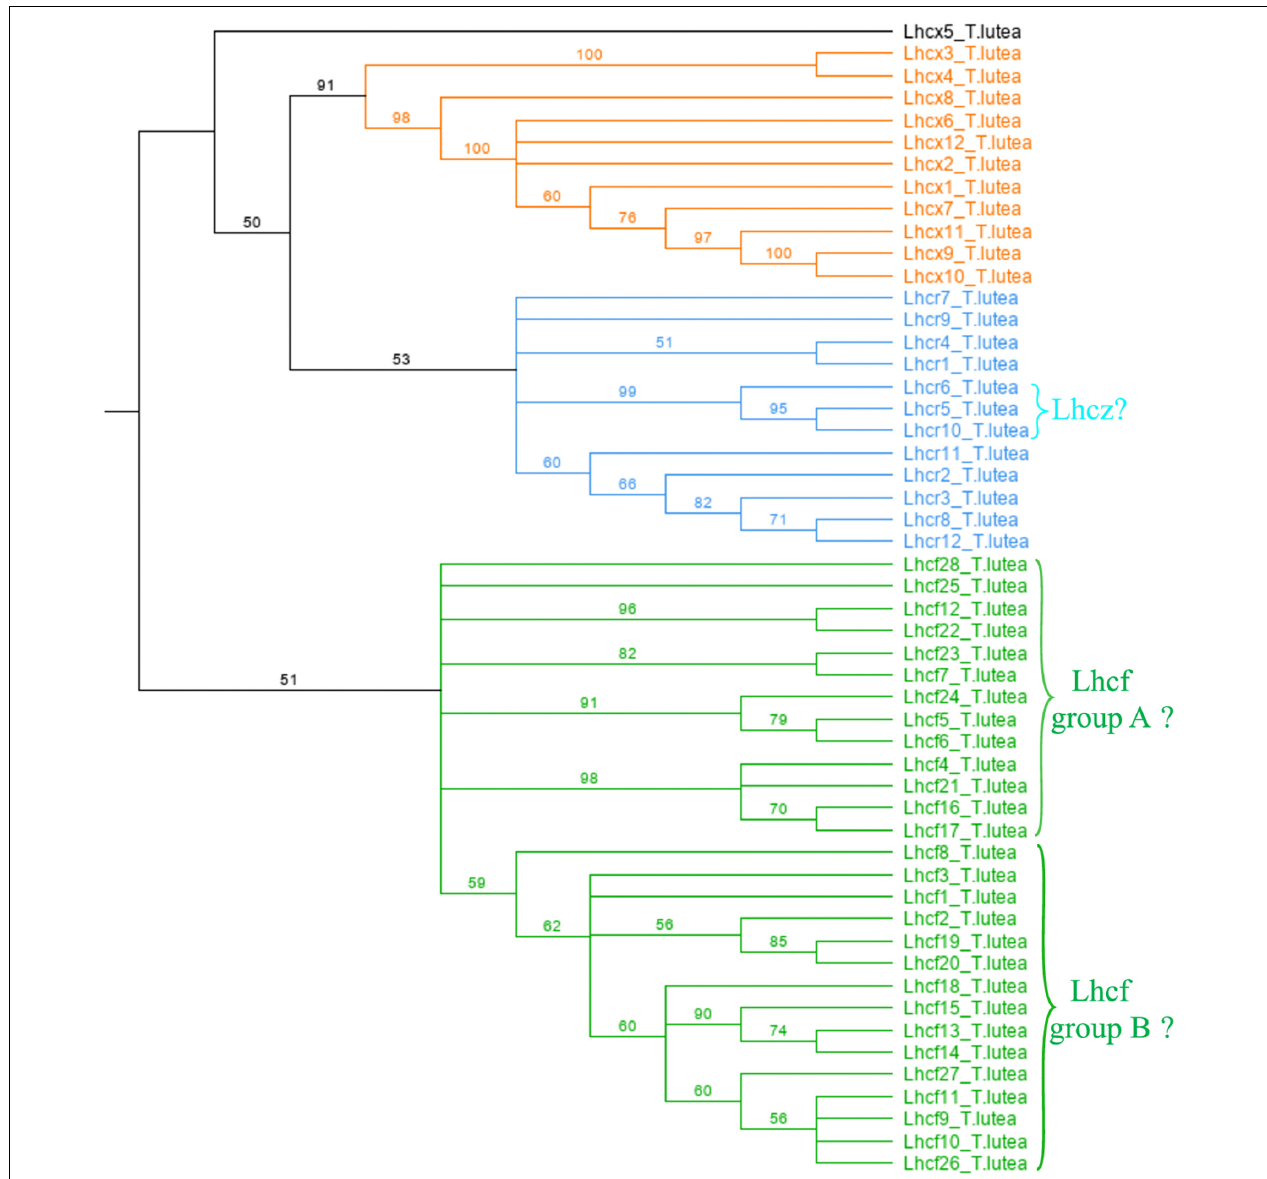
FIGURE 1 | Cladogram of the 52 Lhcf sequences of Tisochrysis lutea . Orange: Lhcx. Blue: Lhcr. Green: Lhcf.